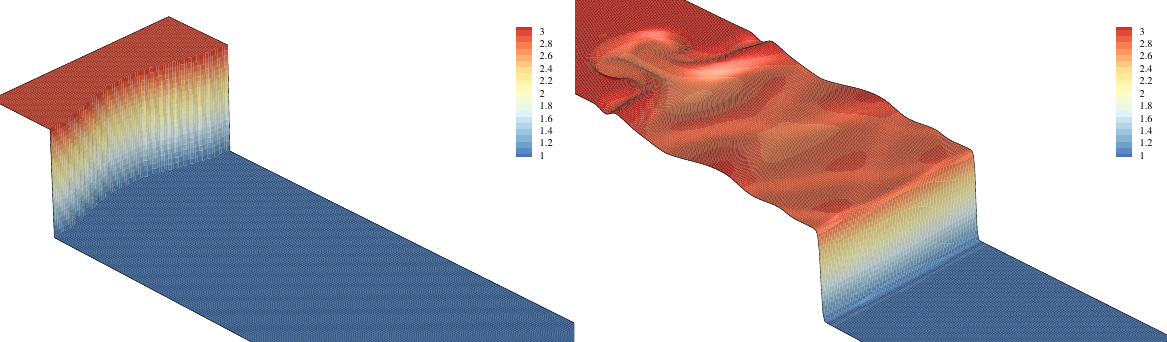
Figure 9. Case(1): Left : Initial perturbation on the shock front. Right : Evolution of the shock-front at time τ = 9.73. Both plots and their coloring, show reduced density with respect to the pre-shock value ρ / ρ 0 .